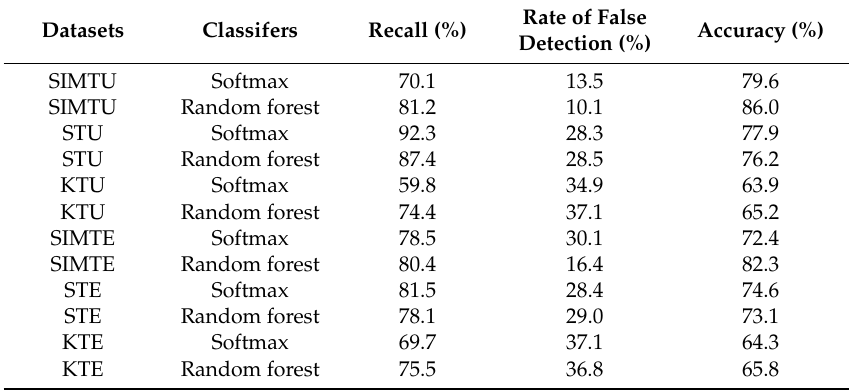
Table 8. Performance of softmax and random forest classifiers on simulated and real data. Datasets